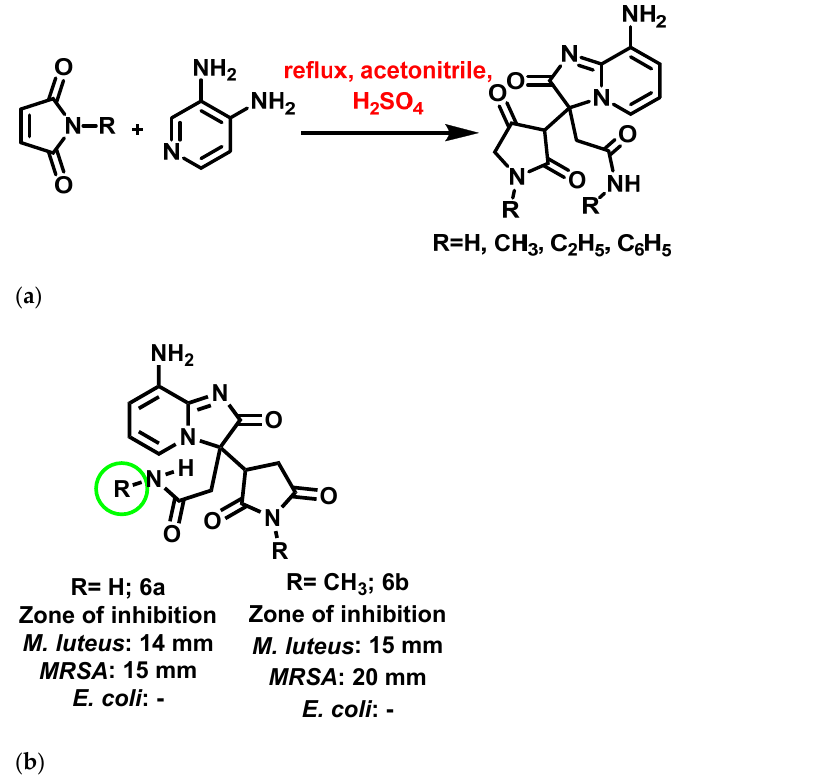
Figure 7. ( a ) Synthetic scheme of dihydroimidazo [1,2 ‐ a]pyridine derivatives. Signatures of com ‐ pounds according to Salhi et al., 2019 [61]. ( b ) Most potent dihydroimidazopyridines in the study. Signatures of compounds according to Salhi et al., 2019 [61].